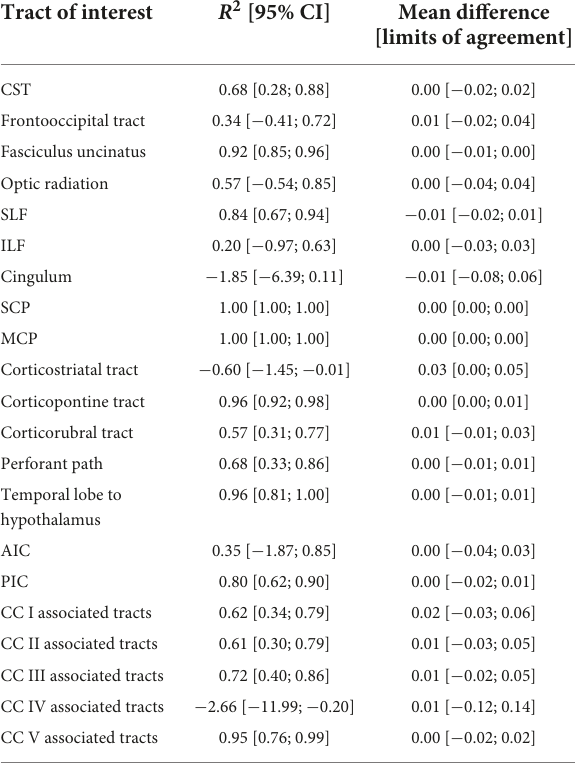
TABLE 3 Performance metrics of the ANN-based age correction of fractional anisotropy (FA) compared to a tract-wise linear